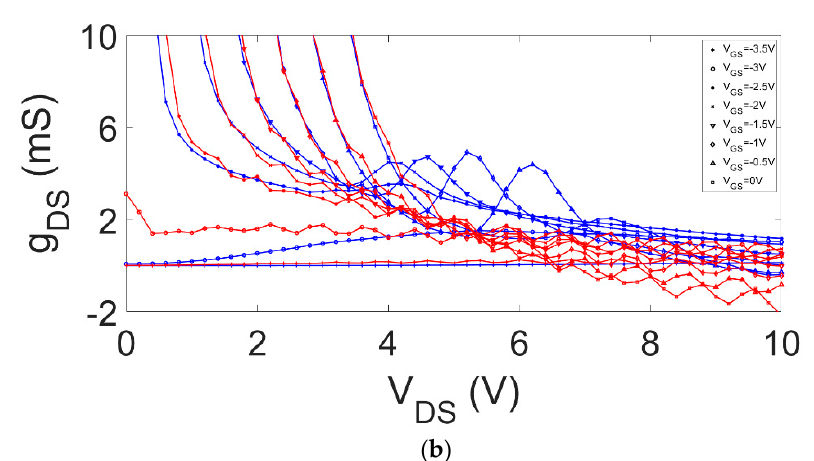
Figure 4. Close-up view curves of g DS versus V DS with V GS from − 3.5 V to 0 V (step 0.5 V) measured for ( a ) the 100 µm HEMT and ( b ) the 200 µm HEMT without (blue line) and with (red line) laser exposure.